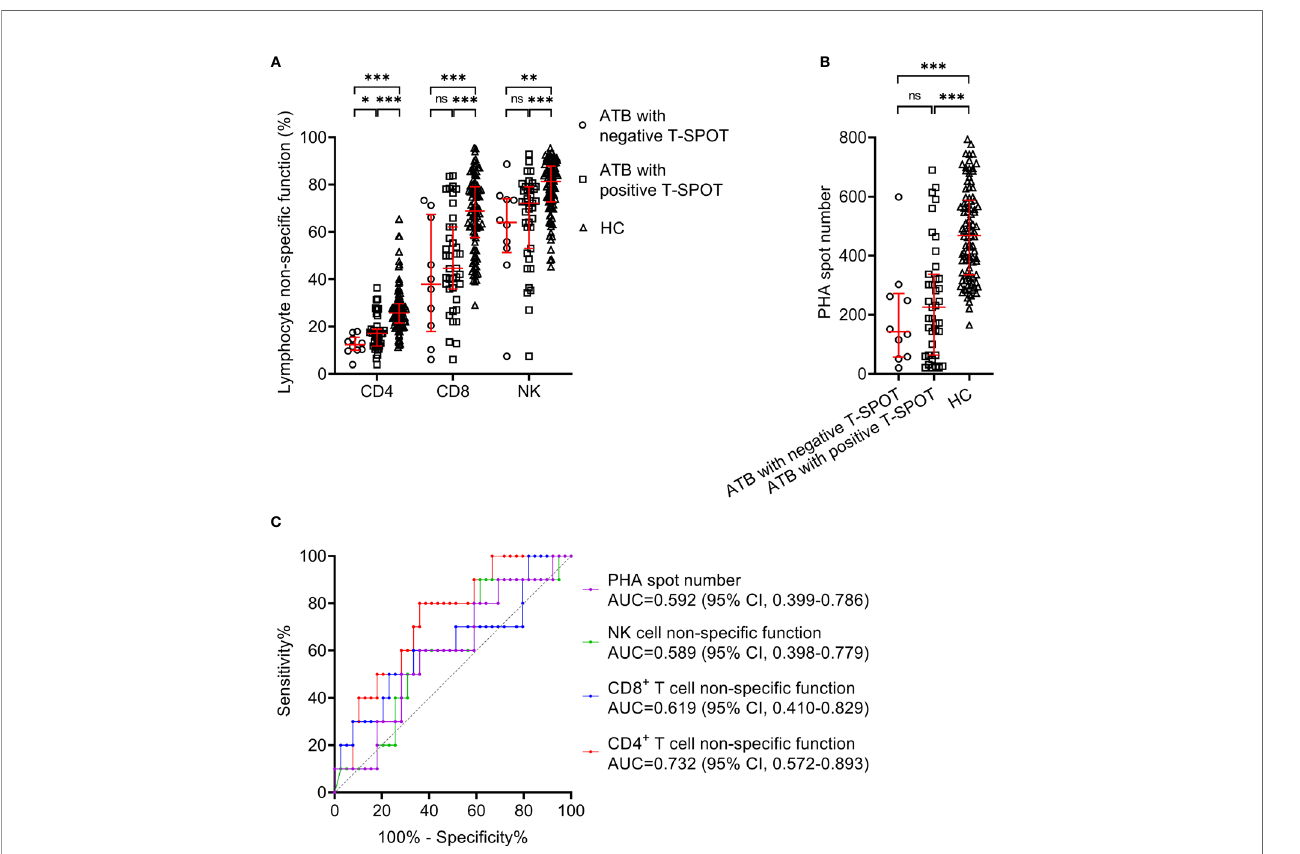
FIGURE 2 | Lymphocyte non-speci fi c function detection for identifying ATB patients with false-negative T-SPOT result. (A) Scatter plots showing the results of lymphocyte non-speci fi c function in ATB with negative T-SPOT result (n=10),ATB with positive T-SPOT result (n=39) and HC (n=95). Bars indicated the medians and interquartile ranges. * P < 0.05; ** P < 0.01; *** P < 0.001; ns, no signi fi cance (Mann-Whitney U test). (B) Scatter plots showing PHA spot number in ATB with negative T-SPOT result (n=10), ATB with positive T-SPOT result (n=39) and HC (n=95). Bars indicated the medians and interquartile ranges. *** P < 0.001; ns, no signi fi cance (Mann-Whitney U test). (C) ROC analysis showing the performance of CD4 + T cell non-speci fi c function, CD8 + T cell non-speci fi c function, NK cell non-speci fi c function, and PHA spot number in distinguishing ATB patients with negative T-SPOT result from those with positive T-SPOT result. ATB, active tuberculosis; HC, healthy controls; PHA, phytohemagglutinin; ROC, receiver operating characteristic; AUC, area under the curve; CI, con fi dence interval.